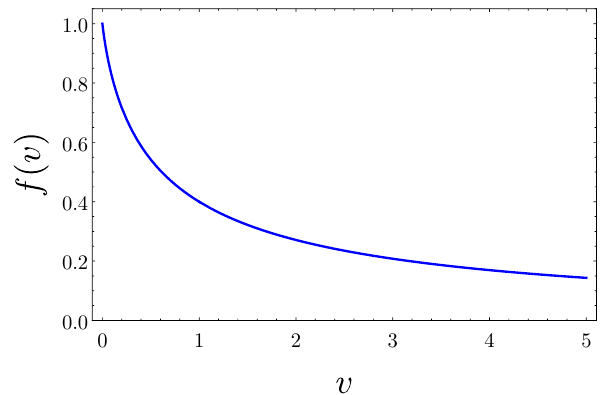
Figure 1 . Function f ( v ) defined in (4.68) that controls the shift to the mass (4.67). Observe that it is smooth everywhere and that it is positive, meaning that the mass is corrected negatively, in agreement with the mild form of the